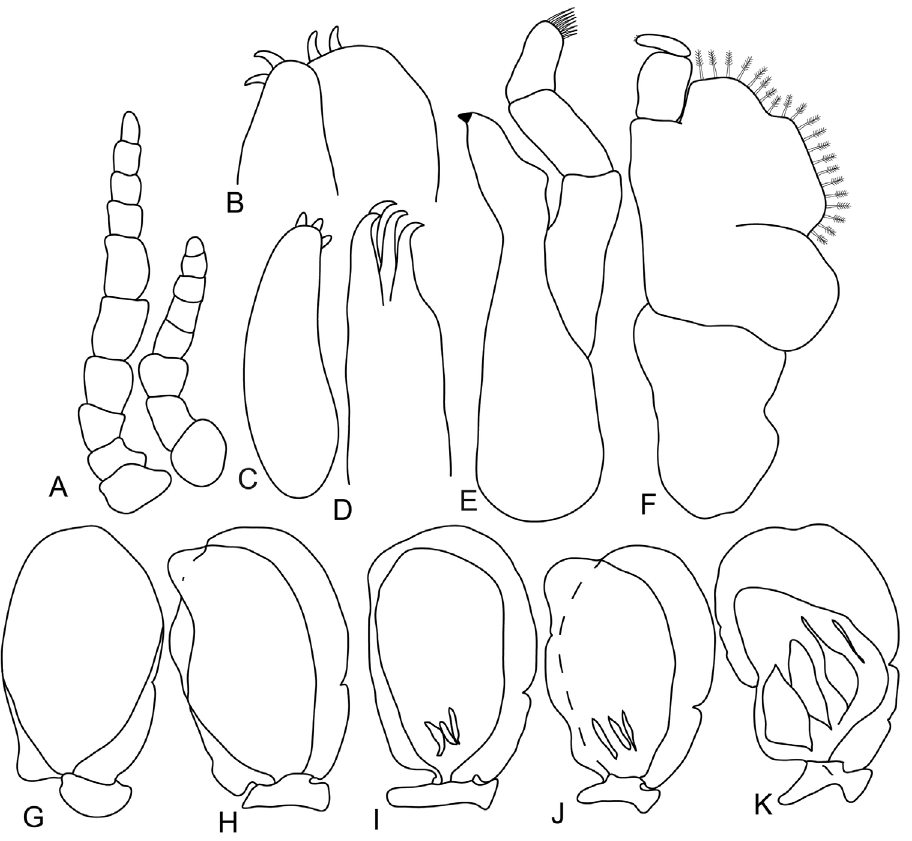
Figure 2. Anilocra haemuli female (23 mm) A, G–K Anilocra haemuli female (25 mm) B–F : A antenna (left) and antennula (right) B maxilla C article 3 of maxilliped D maxillule E mandible F maxilliped G–K pleopods 1–5